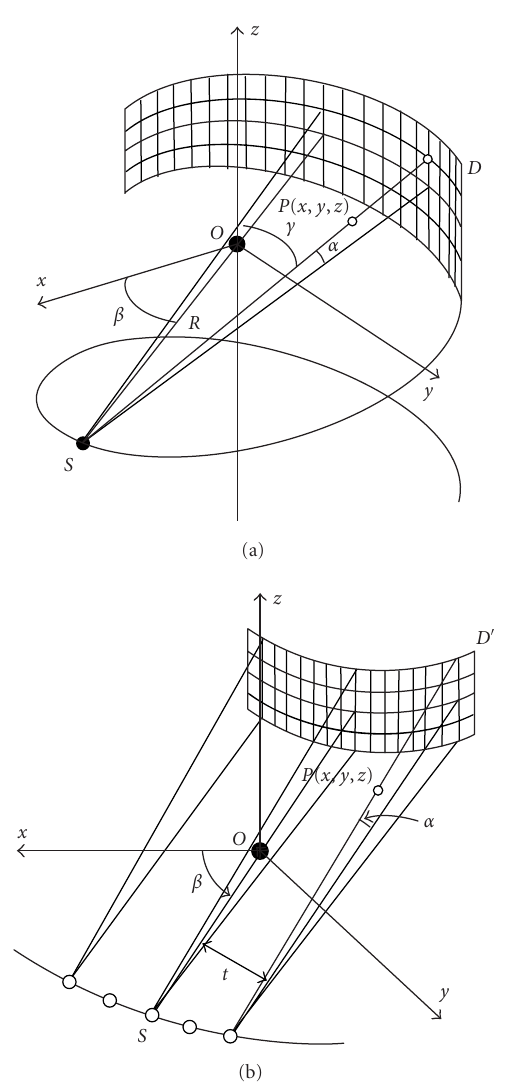
Figure 1: Schematic diagrams showing the geometries in which the extended 3D weighted helical CBFBP reconstruction algorithm is derived: (a) the native CB geometry; (b) the cone-parallel